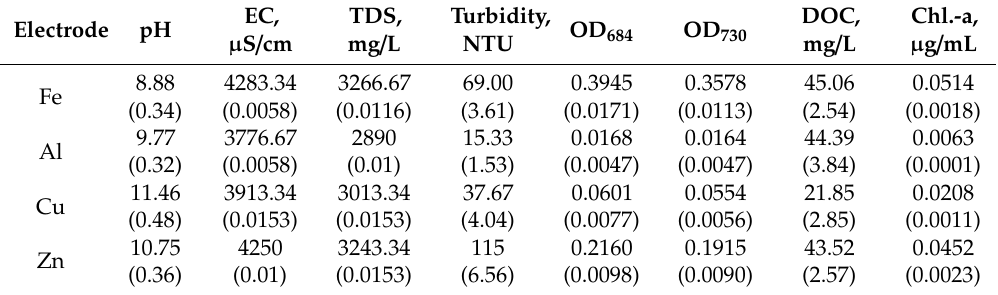
Table 4. Characteristics of M. aeruginosa suspensions treated using di ff erent anode materials ( n = 3).